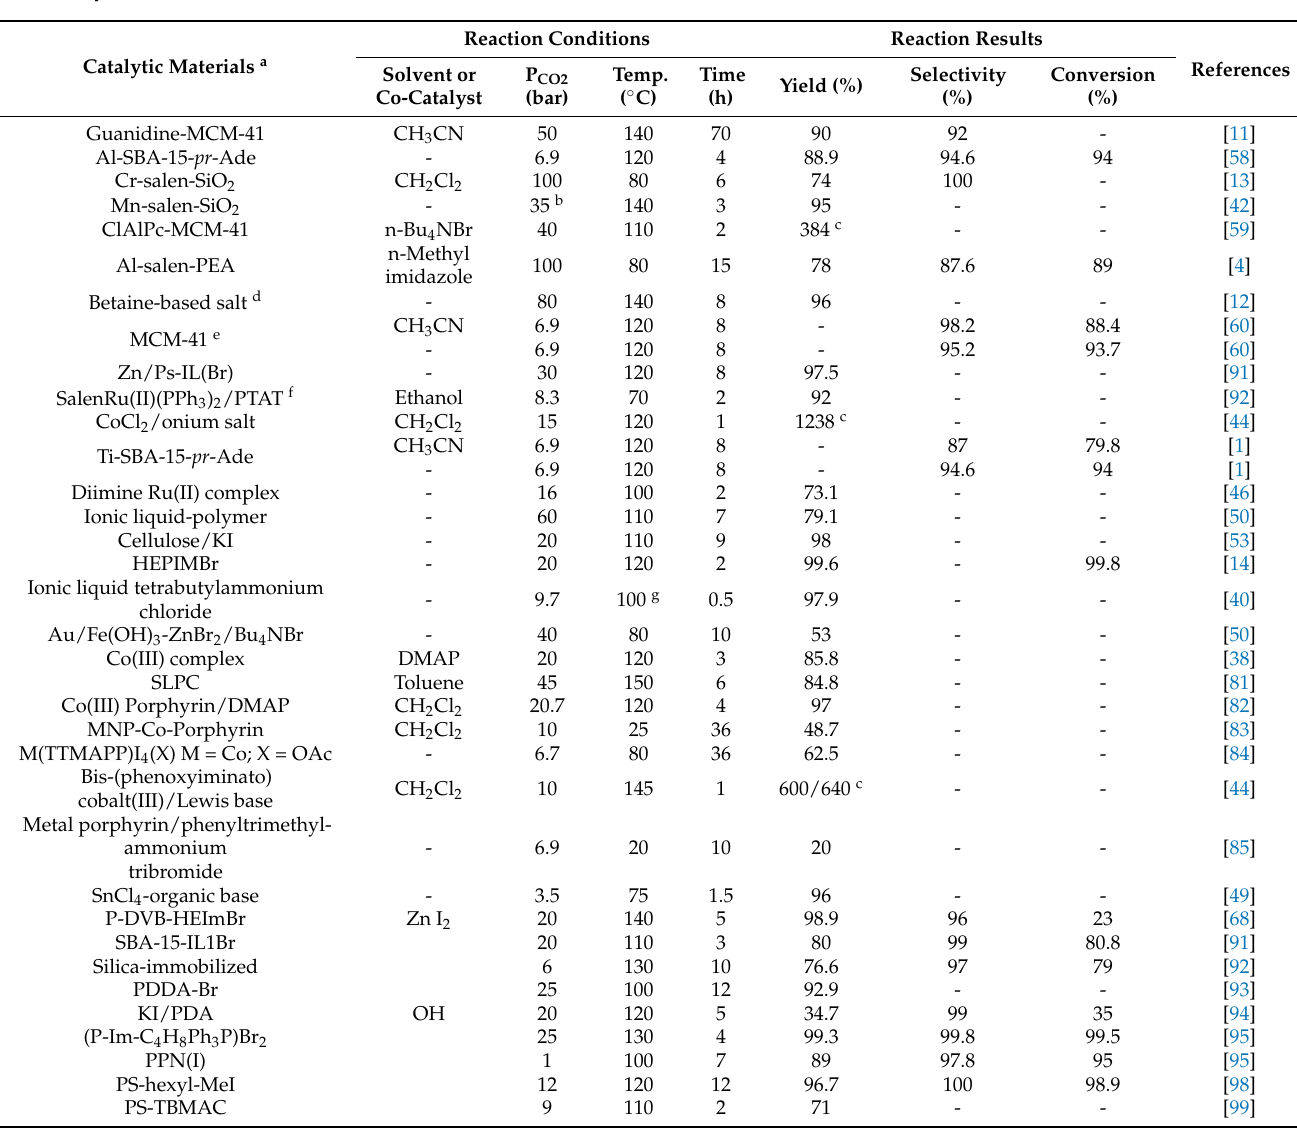
Table 1. Catalytic activity studies of cycloaddition of CO 2 to styrene oxide using various homogeneous and heterogeneous